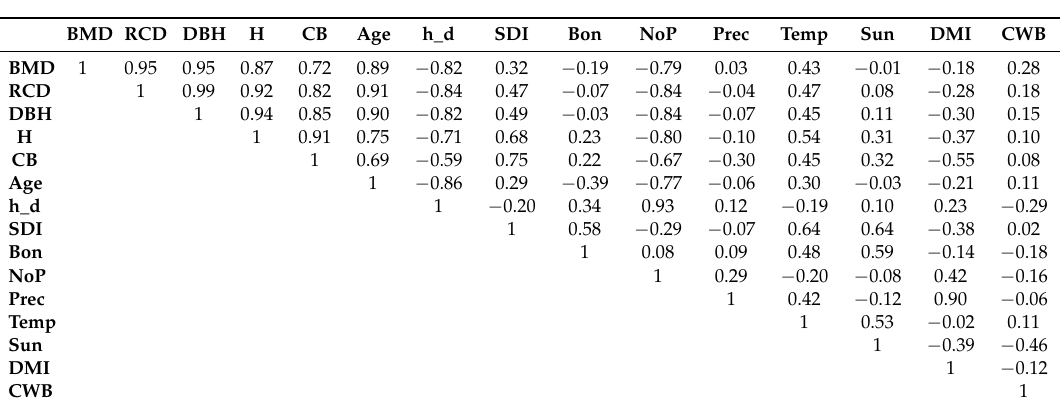
Table 4. Correlation among mean tree and stand variables for Robinia pseudoacacia